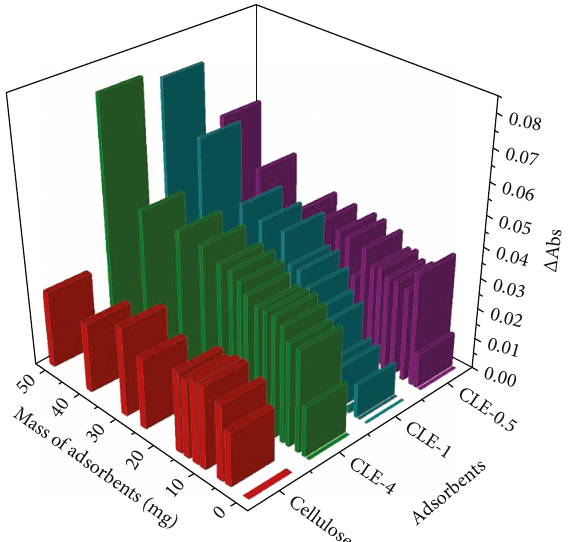
Figure 6: Phenolphthalein decolorization in aqueous solution with variable amounts of cellulose and cross-linked polymers at 295 K and